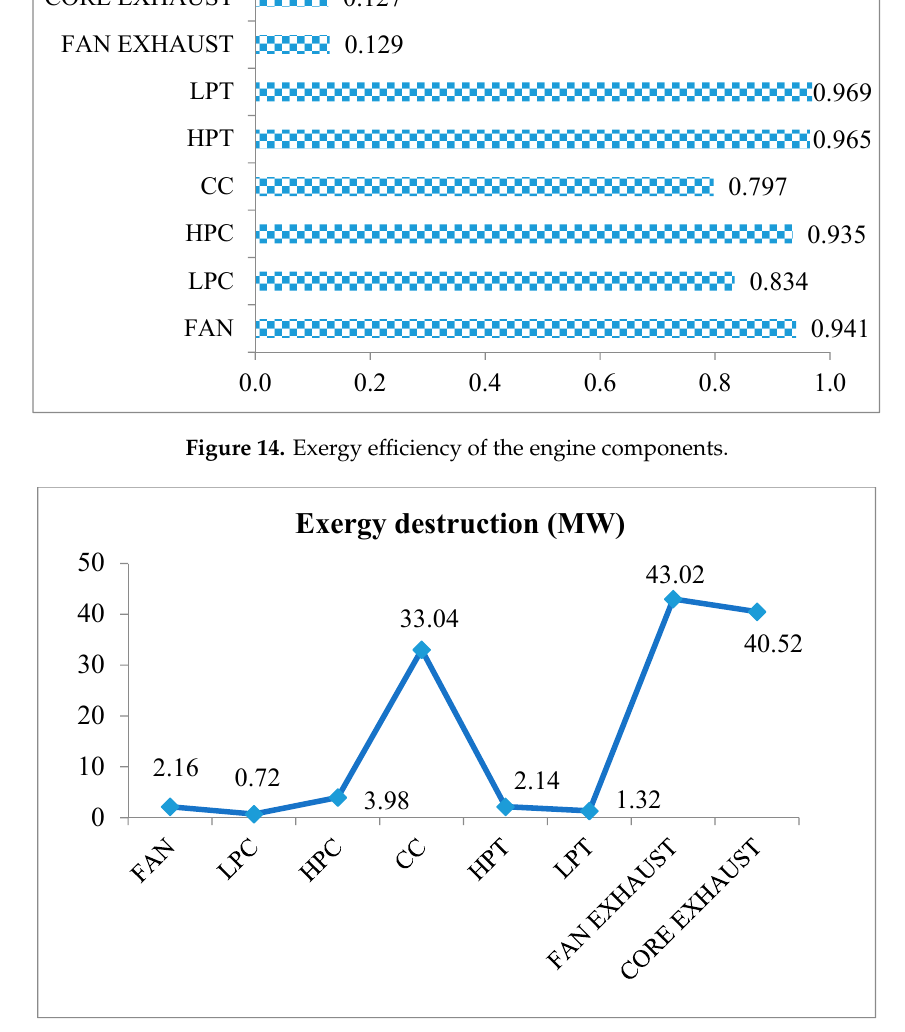
Figure 15. Exergy destruction rates of each component.